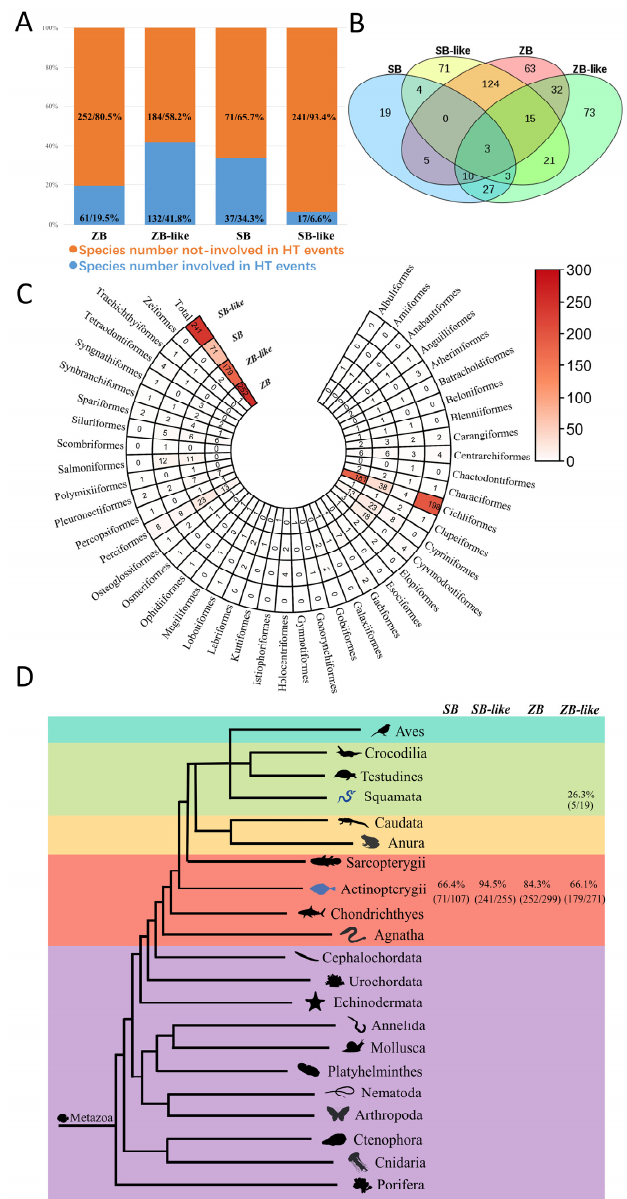
Figure 6. Taxonomic distribution and HT events of ZB and SB elements. This refers to the HT events jointly supported by two cytoplasmic ribosomal proteins (L3 and L4) in eukaryotic species (detailed information of species was listed in Supplementary Tables S5 and S6). ( A ) The number and proportion of species involved in HT events for the four transposons. ( B ) Venn of species number involved in HT events of ZB , ZB -like, SB , and SB -like. ( C ) Species number involved in HT events in Actinopterygii. ( D ) Species number involved in HT events in